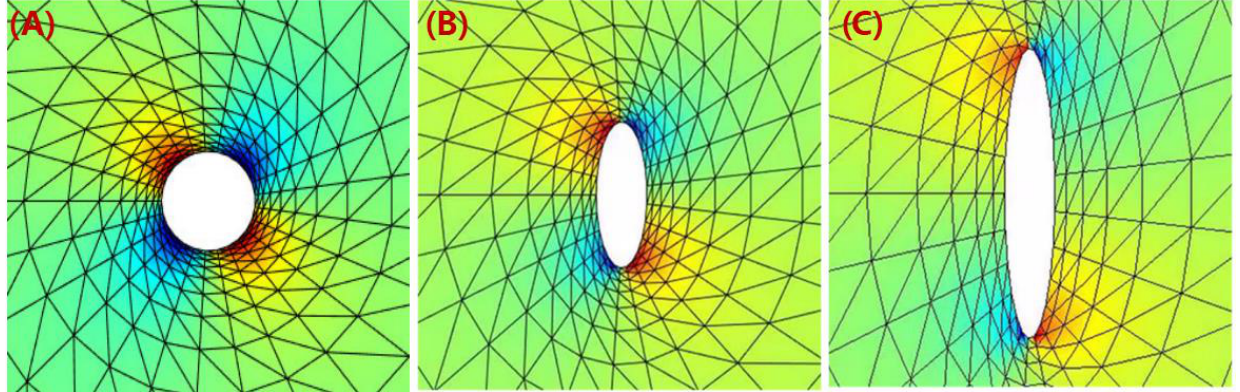
Figure 21. Pressure Distribution around fiber surface: ( A ) γ e = 1; ( B ) γ e = 3; ( C ) γ e = 6. Of note, γ e represents the fiber aspect ratio of an ellipsoidal fiber.